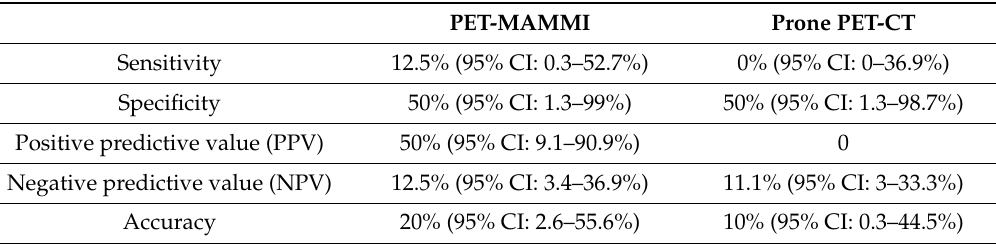
Table 3. Diagnostic accuracy measures (with 95% confidence intervals) for PET-MAMMI and prone PET-CT (statistics derived from https: // www.medcalc.org / calc / diagnostic_test.php). PET-MAMMI: TP = 1, FN = 7, FP = 1, TN = 1, meaning a = 1, b = 7, c = 1, d = 1 Prone PET-CT: TP =